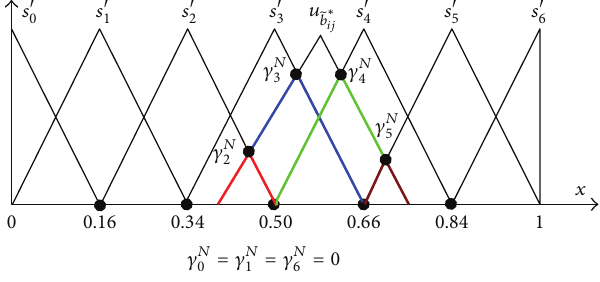
Figure 1: Illustration of transforming a triangular number to a linguistic term in BLTS.